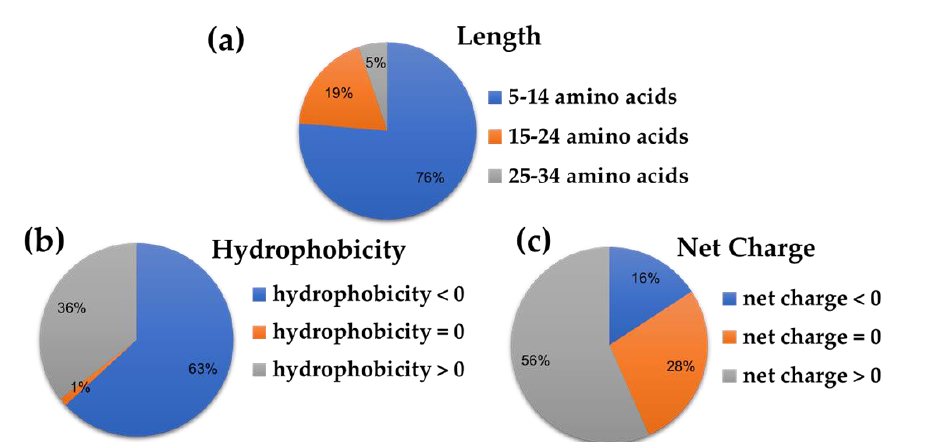
Figure 2. Percentage of the peptides’ properties with respect to their ( a ) length, ( b ) hydrophobicity, and ( c ) net charge based on 71 putative AVPs.